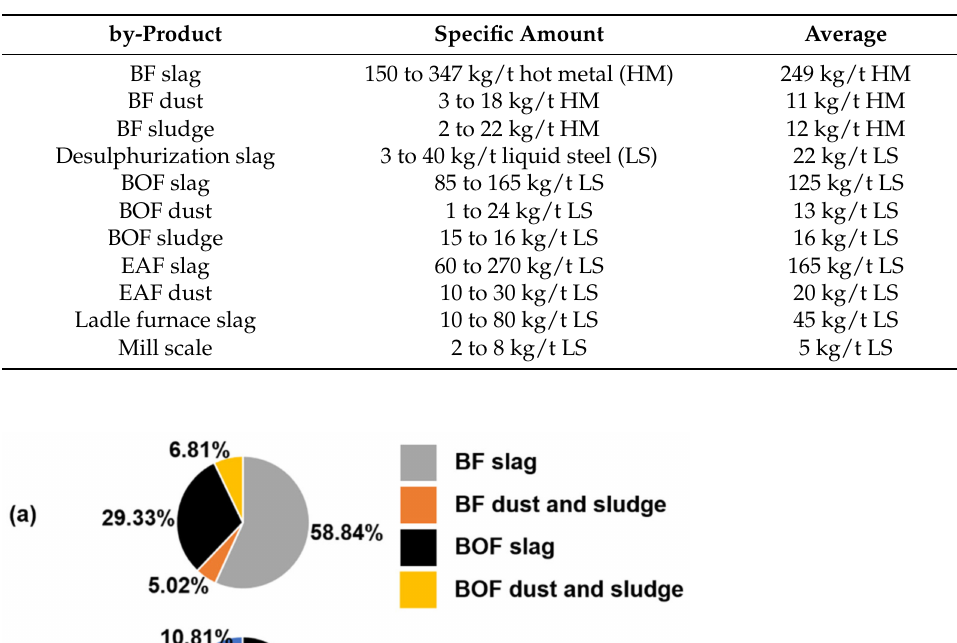
Table 1. Specific amounts of steelmaking by-products [6–10].